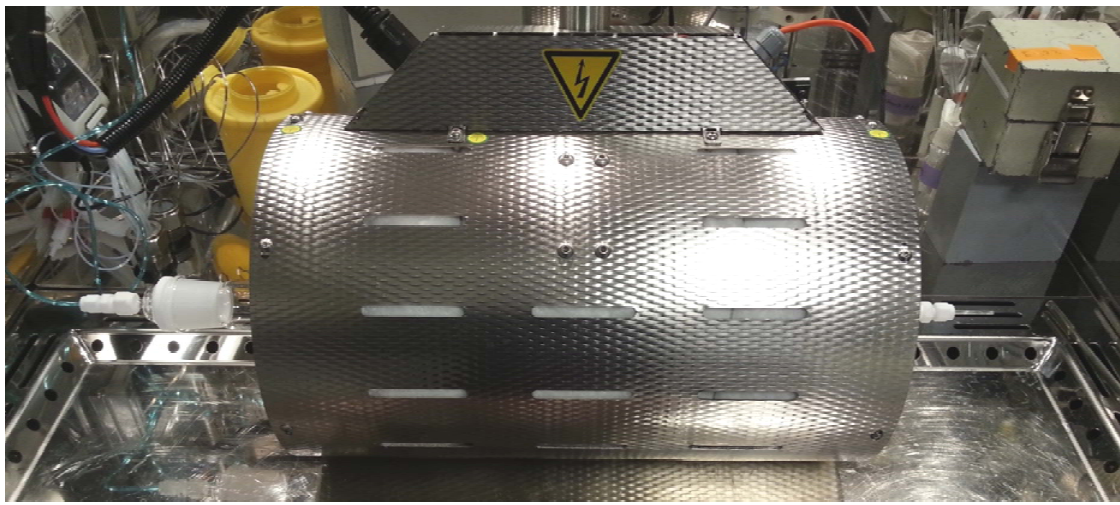
Figure 1. Image of the setup in use. Air introduced from the left carried the distilled iodine from the target in the middle of the tube furnace, to the capillary tube on the far right, on which it